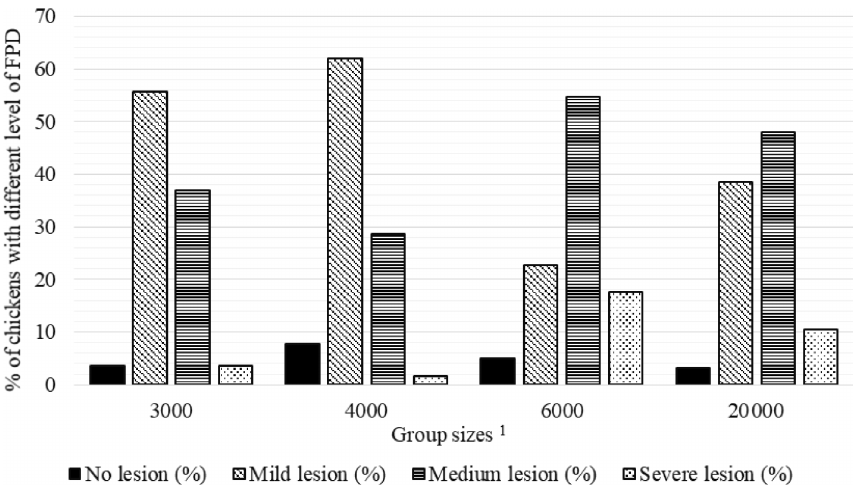
Figure 1. Percentage of chickens with different level of foot pad dermatitis (FPD) in varying group sizes. 1 The 3000, 4000, 6000, and 20000 numbers represent the number of chickens in the each group size.